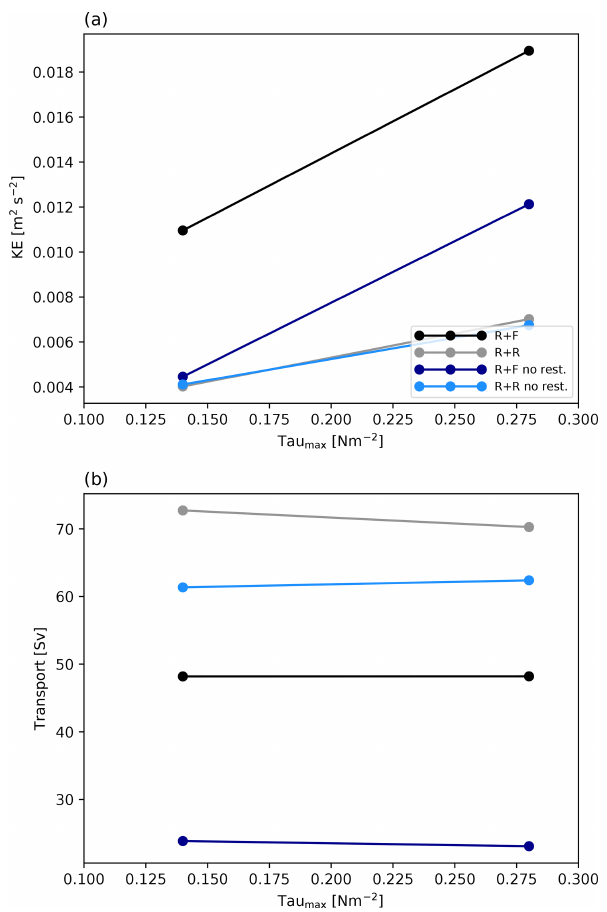
Figure 11. Sensitivity of (a) domain-averaged KE (m 2 s − 2 ) and (b) zonal barotropic transport (Sv) to wind stress increase. Trans- port and KE values were averaged for the last 10 years of simulation once equilibrium was achieved.